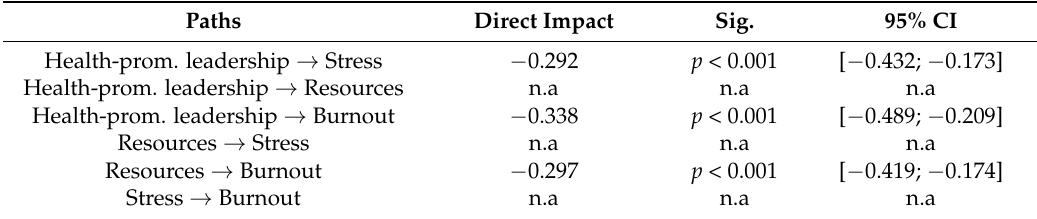
Table 6. Indirect impacts in the structural model—sample 2.